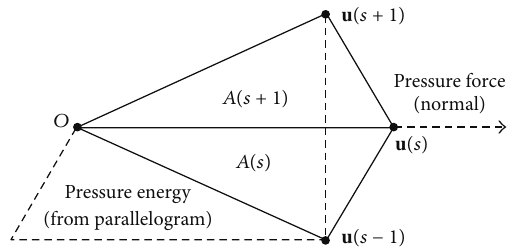
Figure 7: Pressure energy.